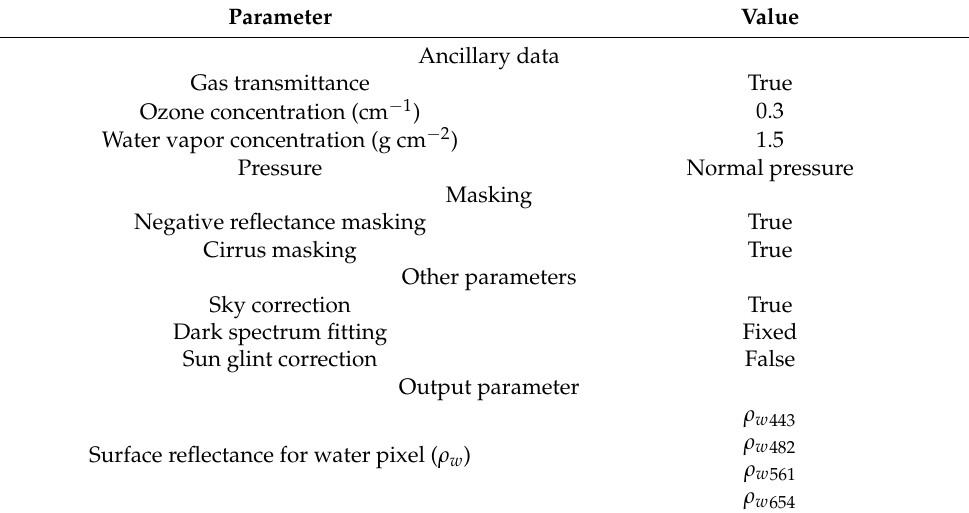
Table A1. Selected parameters for atmospheric correction using